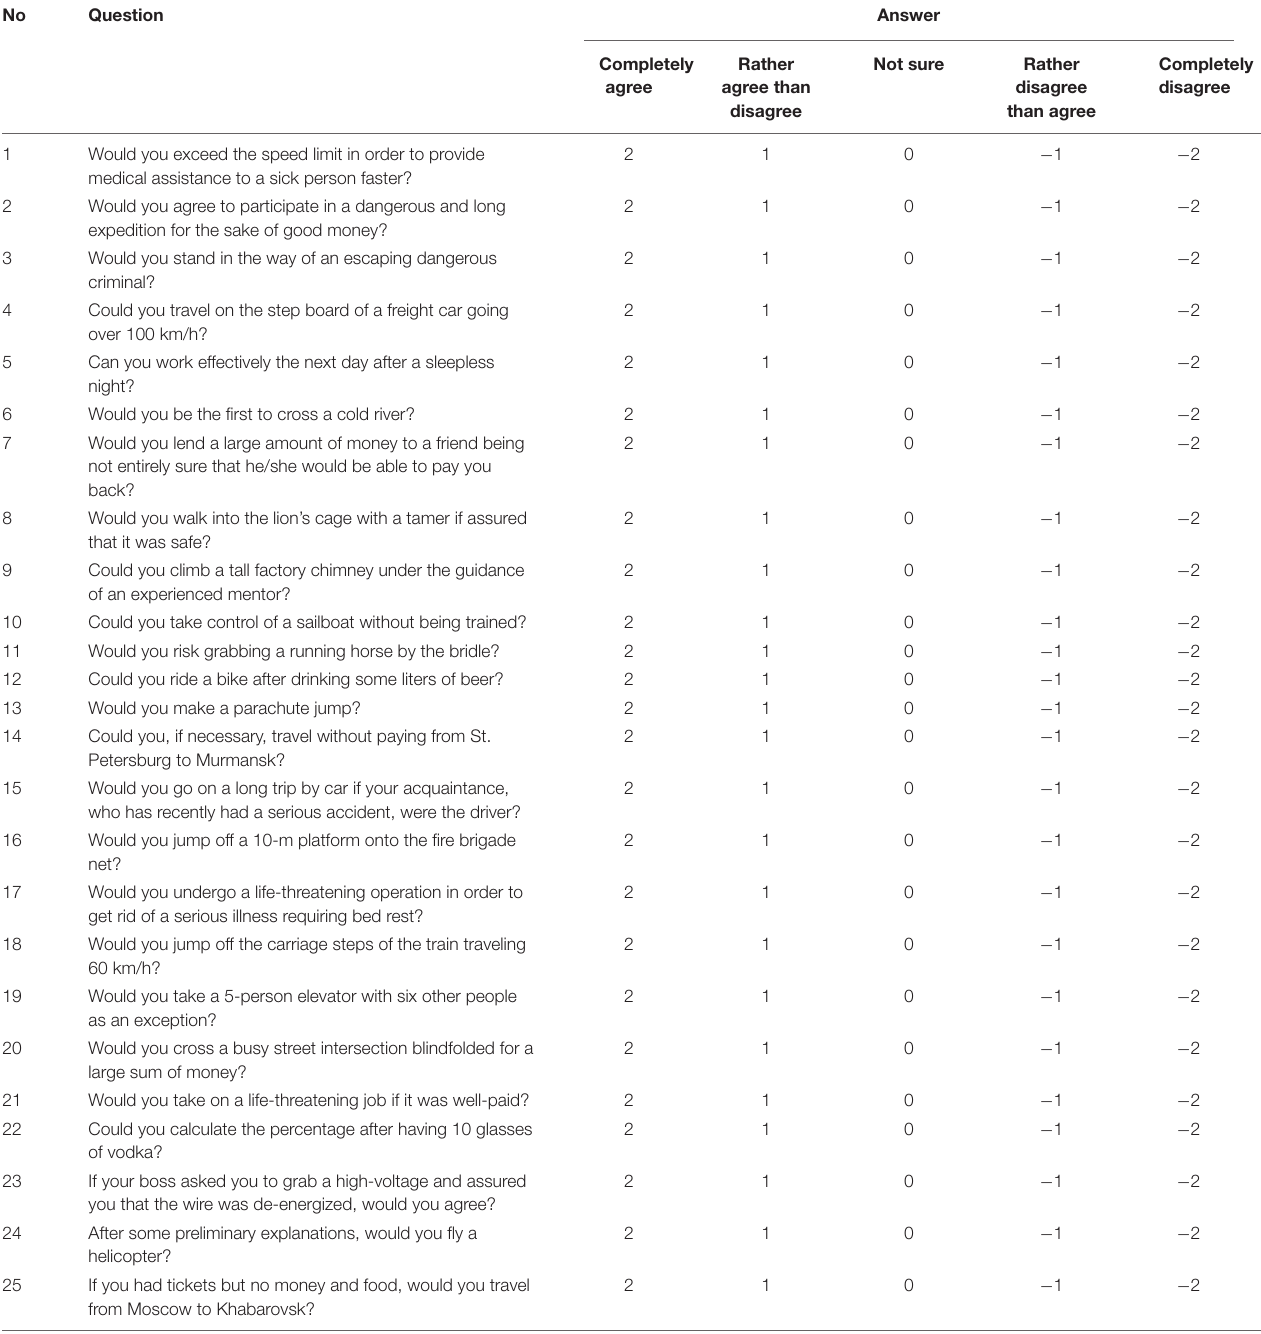
TABLE A2 | Dear social educator! We would like you to kindly answer the questions of the questionnaire within the framework of the research initiated by the Al-Farabi Kazakh National University and Abai Kazakh National Pedagogical University. For your information, assess the degree of your willingness to take the actions that you are asked about. When answering each of the 25 questions, agree or disagree in accordance with the following scale: 2 points – completely agree; 1 point – rather agree than disagree; 0 points – not sure; − 1 point – rather disagree than agree; − 2 points – completely